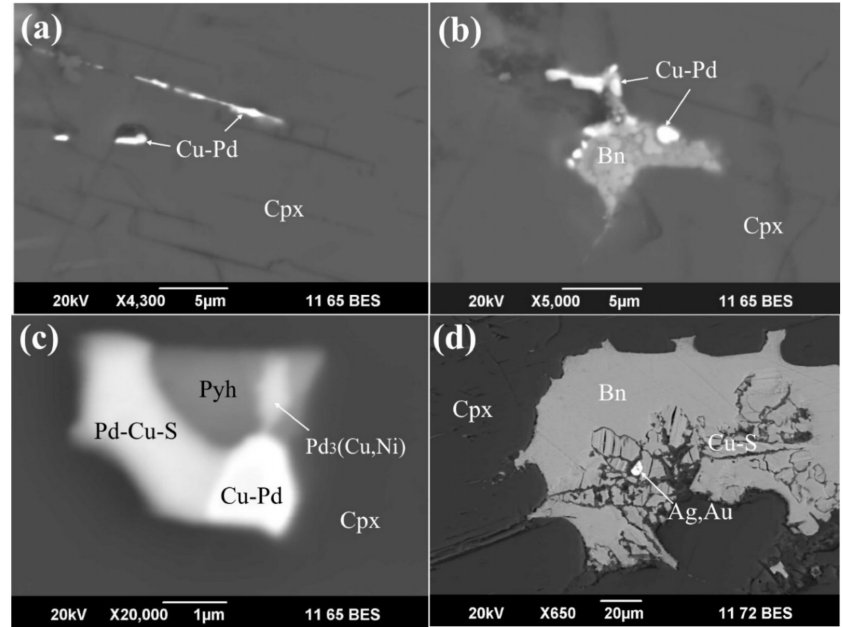
Figure 11. Noble metal minerals in clinopyroxenite II: ( a ) native copper–palladium phases (Cu-Pd) in cleavage cracks in clinopyroxene (Cpx); ( b ) interstitial bornite (Bn) segregation in intergrowth with native copper–palladium phases (Cu-Pd); ( c ) polyphase intergrowth of native Cu-Pd phases (Cu-Pd) (Table 10, No 10), palladium sulfide (Pd-Cu-S) (Table 10, No 12), phases Pd 3 (Cu,Ni) (Table 10, No 11) and pyrrhotite (Pyh) in clinopyroxene (Cpx); ( d ) Au,Ag particle (Table 10, No 13) in secondary copper sulfide (Cu-S) developed on bornite